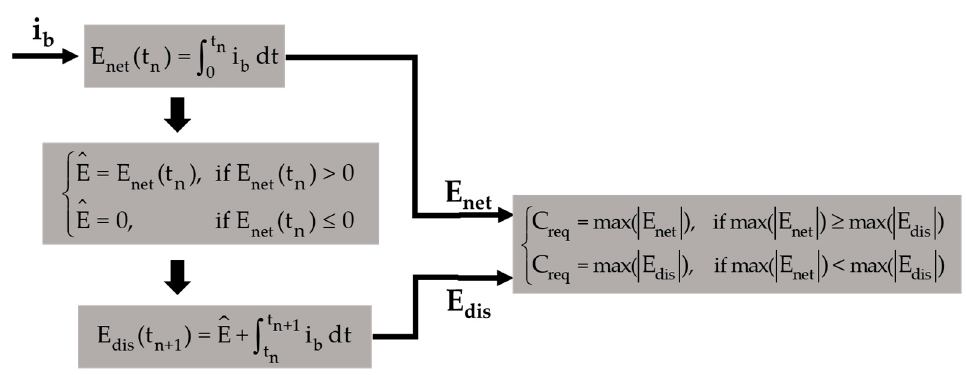
Figure 16. Battery pack sizing algorithm flow chart.